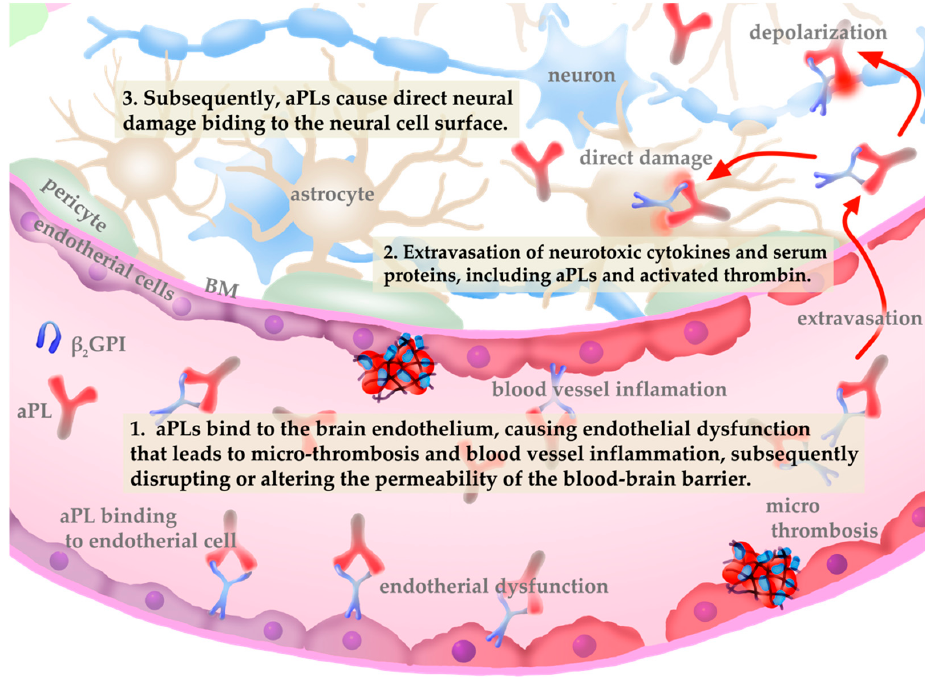
Figure 1. Pathophysiology of central nervous system vasculopathy induced by antiphospholipid antibodies (aPLs).